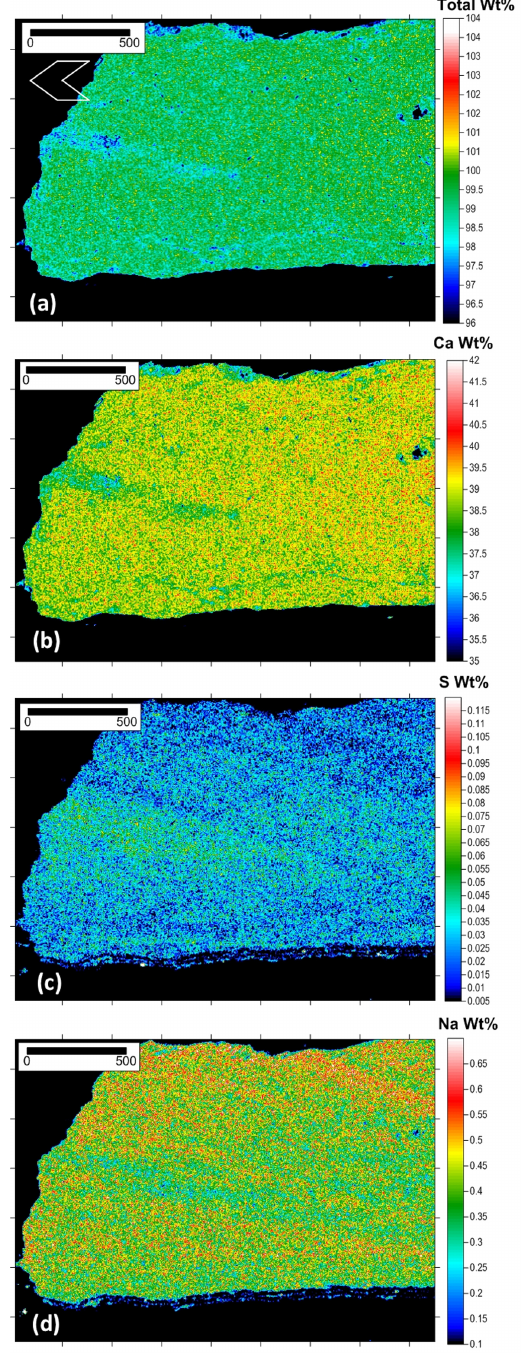
Figure 8. The EPMA elemental map of sample G155, F. tenuicostata , for totals (a) , Ca concentration (b) , S concentration (c) and Na concentration (d) . Mg and Sr were below the instrumental detection limit and are therefore not presented. The dashed line indi- cates scan overlap, since the sample was scanned twice to optimise precision and quality. Scale bar: 500µm. The arrow indicates the direction of growth.